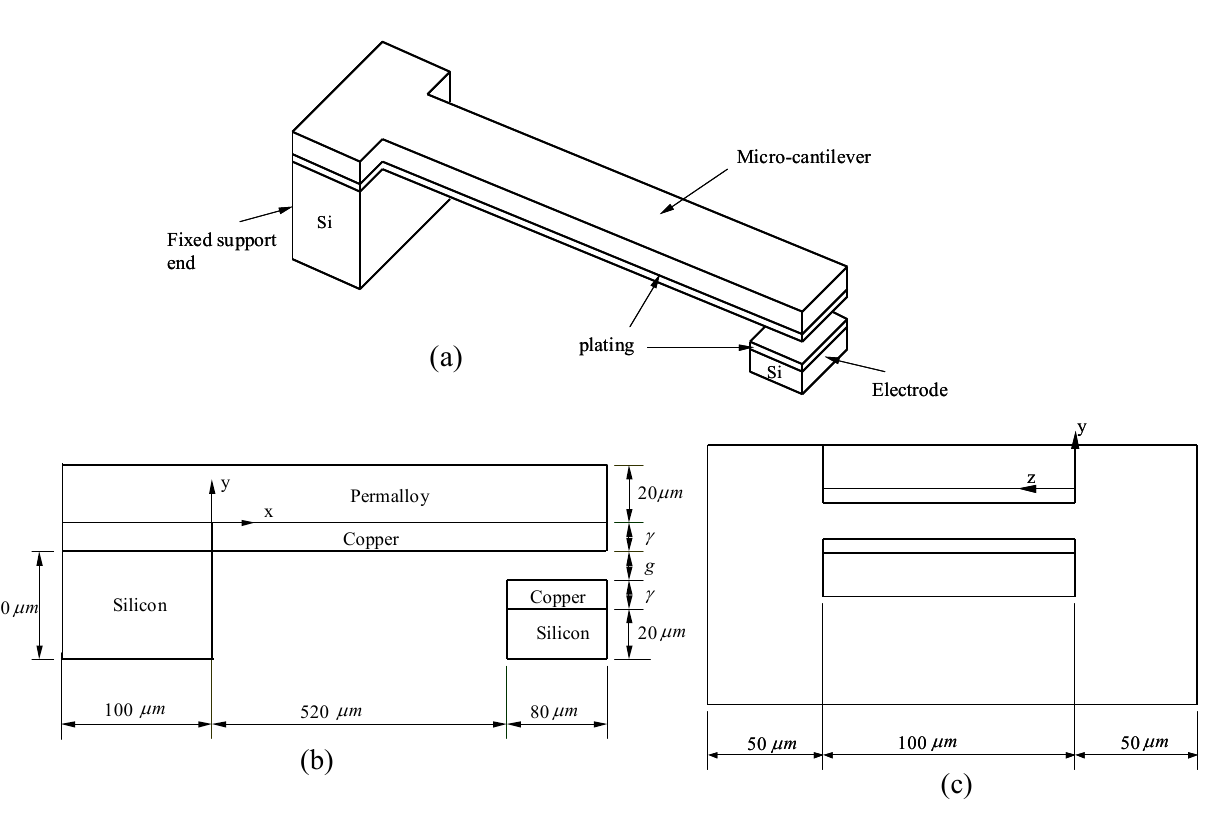
Figure 1. Geometrical configuration of the microrelay